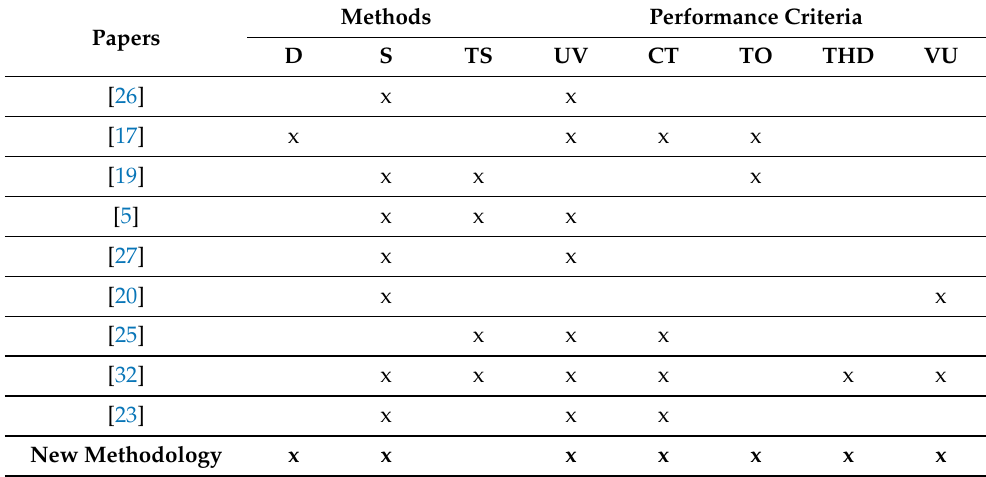
Table 1. List of papers, methods, and performance criteria for evaluating the hosting capacity of EVs.